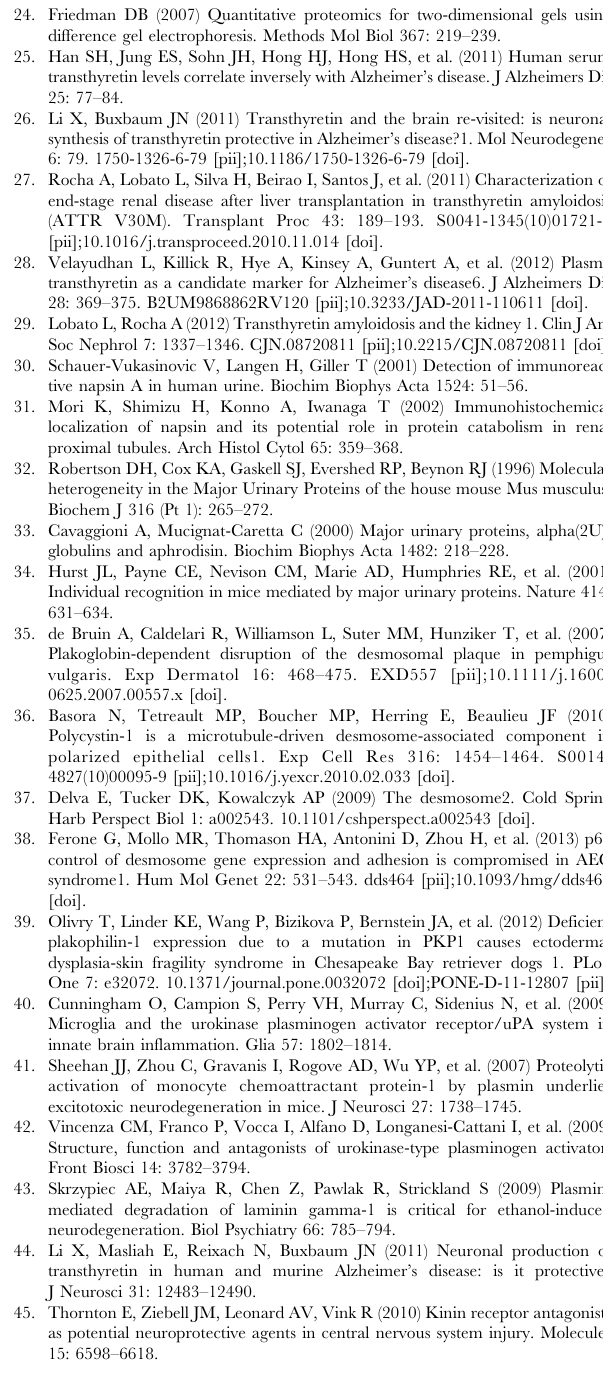
Table S1 Glomerular filtration rate calculations. Table S2 Statistical analysis of glomerular filtration